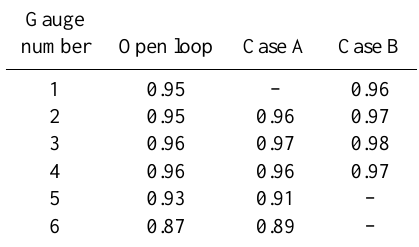
Table 3. Validation at the stream gauge locations without data assimilation. The median Nash-Sutcliffe model efficiency of the 64ensemble members for the open loop simulations and the up- dated simulations being assimilated using Cases A and B.